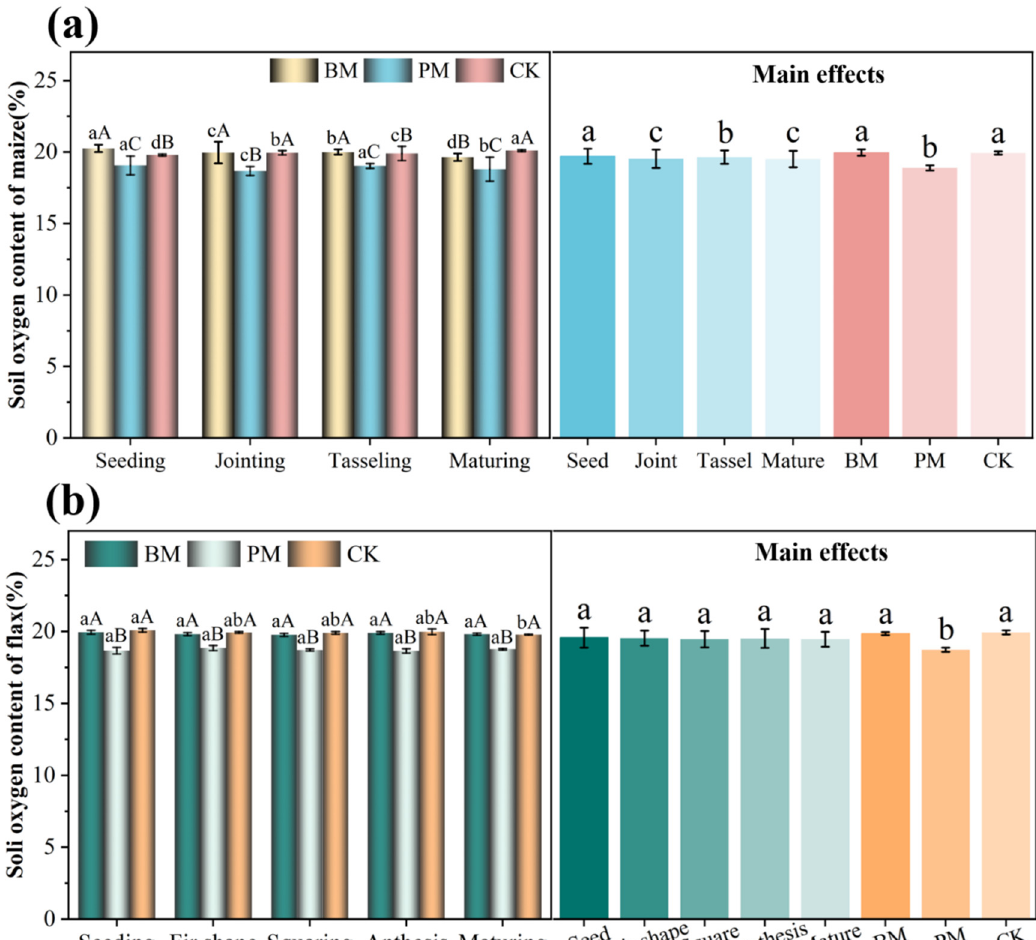
Figure 11. Soil oxygen content affected by mulching materials in ( a ) maize and ( b ) flax in 2021. Values represent the mean ± standard deviation. Using Duncan’s multiple-range test, different lowercase letters indicate significant differences in soil oxygen content under different mulching methods at the same growth period ( p < 0.05); different capital letters indicate significant differences in soil oxygen content at different growth stages under the same mulch control ( p < 0.05). BM, biodegradable paper mulch film; PM, white plastic mulch film; CK, not covered with